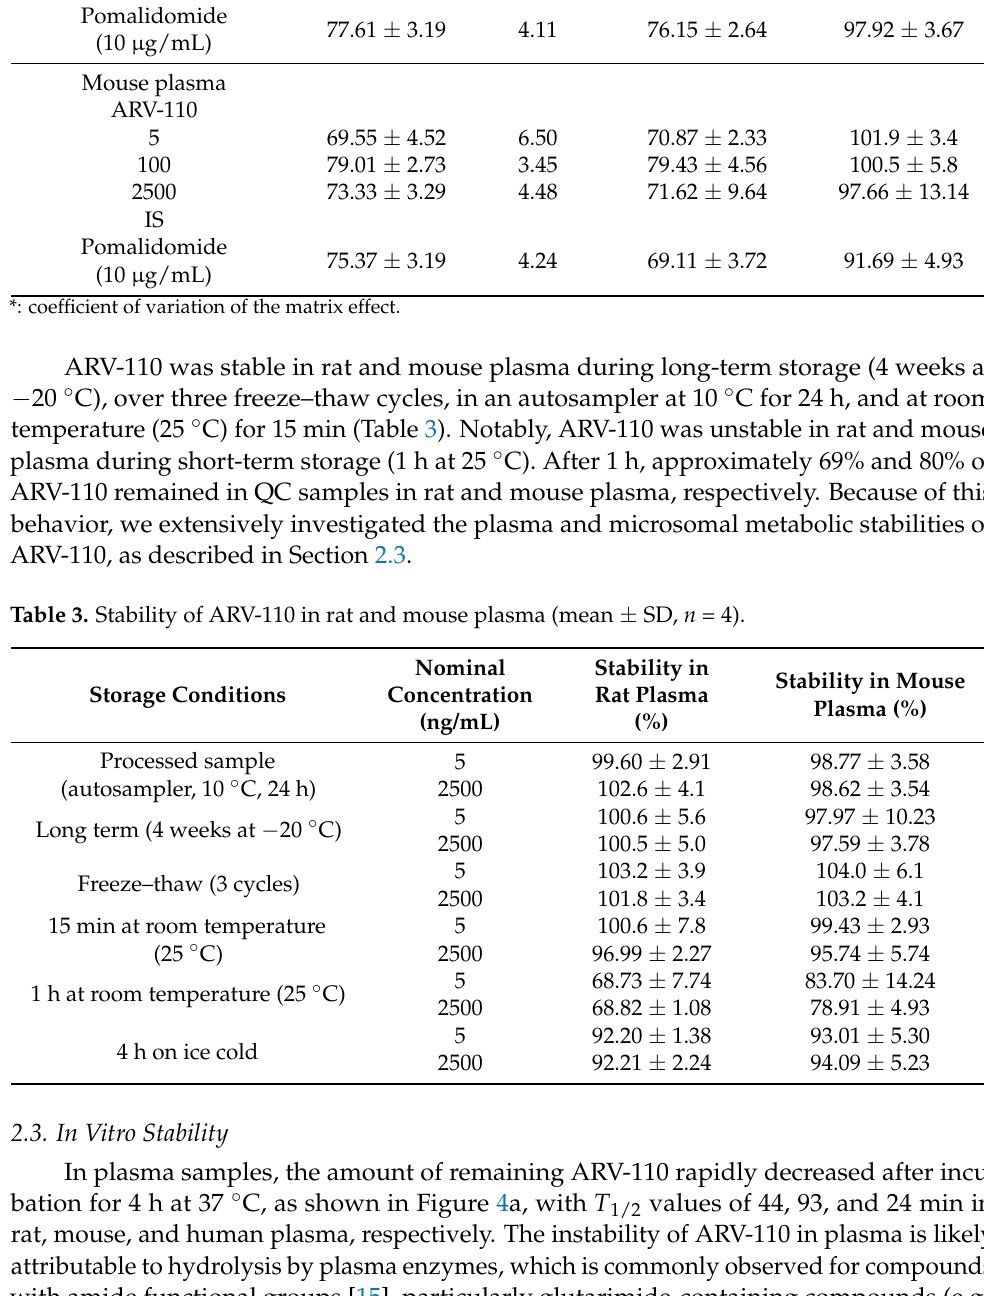
Table 2. Matrix effect, process efficiency, and extraction recovery of the assay in rat and mouse plasma ( n = 5).